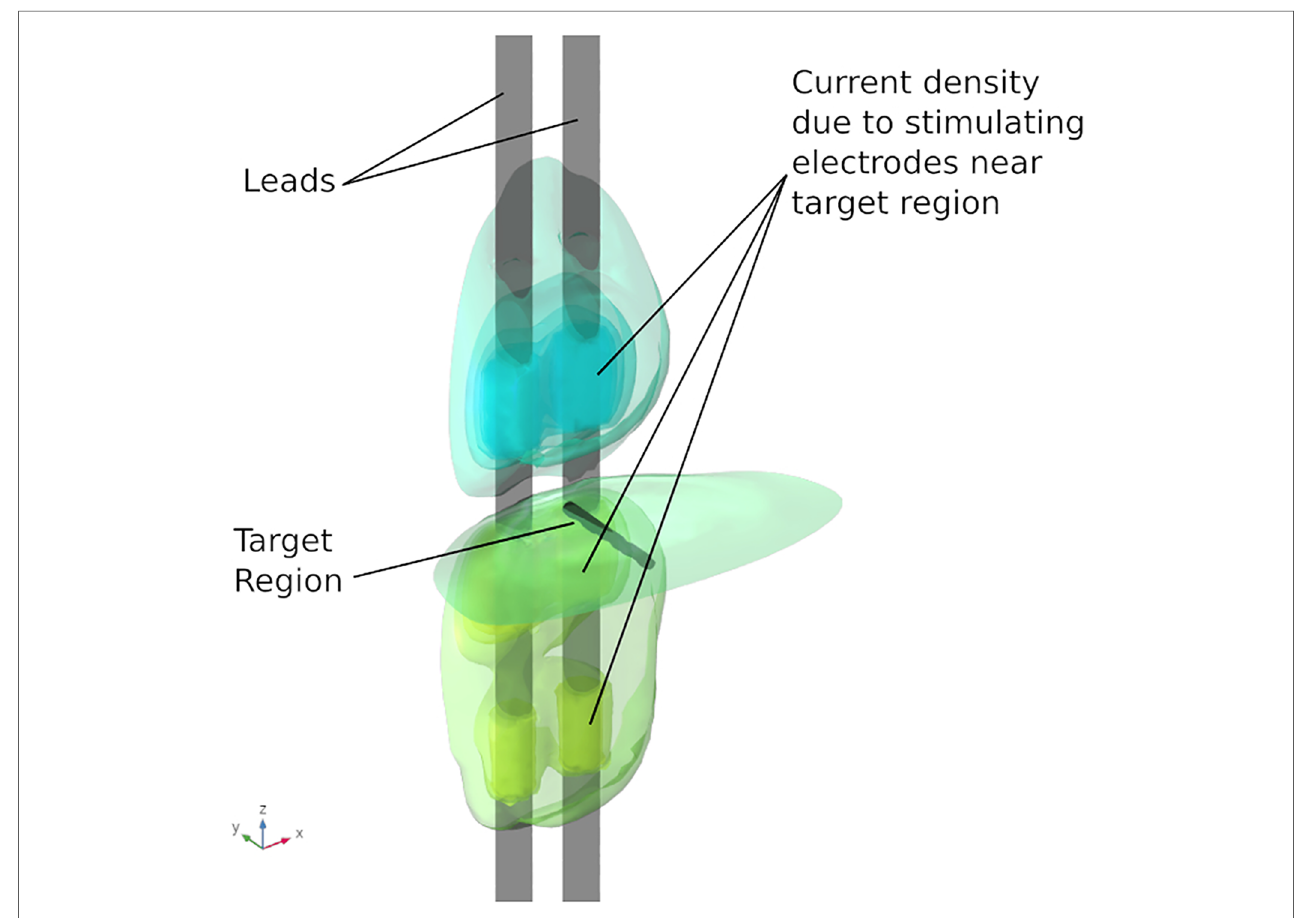
FIGURE 7 Current density near target region. The electrodes in the immediate vicinity of the target region are